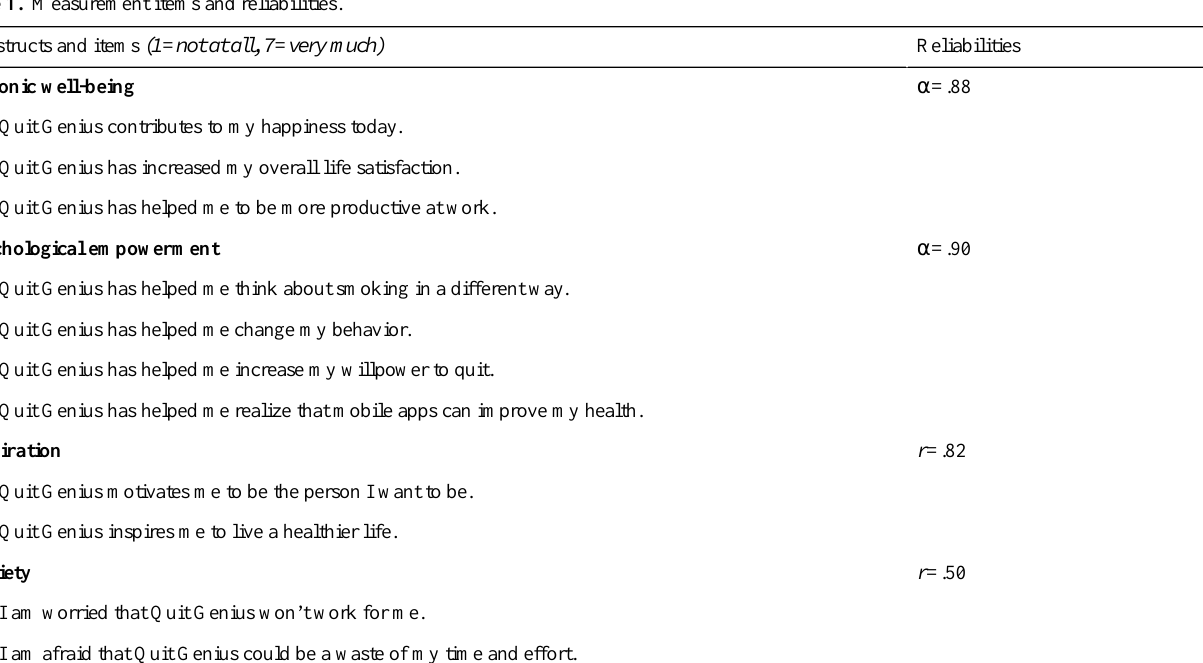
Table 1. Measurement items and